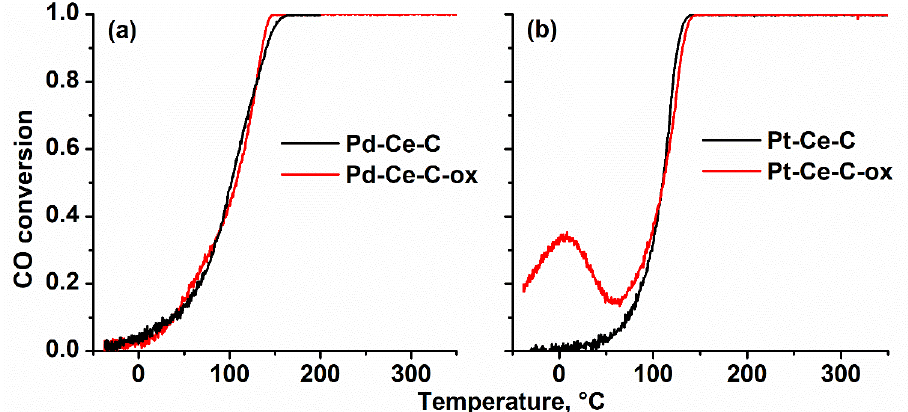
Figure 5. TPR-CO+O 2 data. The temperature dependences of CO conversion during the third heating run of the samples in the reaction mixture in the TPR-CO+O 2 mode. ( a ) Pd-Ce-C and Pd-Ce-C-ox catalysts; ( b ) Pt-Ce-C and Pt-Ce-C-ox catalysts. For the Pd-based catalysts, the observed temperature dependence of CO conversion shows a classical S-shaped behavior (Figure 5a). CO conversion is observed already at temperatures below 20–25 °C. The temperatures of 10 and 50% of CO conversion (T 10 and T 50 values) are 35 and 100 °C, respectively. It should be noted that the temperature de- pendences of CO conversion practically coincide during the second and third heating runs in the reaction mixture (see Figure A4), pointing to stability of the catalytic charac- teristics. The TPR-CO+O 2 data for the initial sample (Pd-Ce-C) and the sample treated in 1%O 2 /He (Pd-Ce-C-ox) are very similar. Thus, pretreatment of the Pd-based sample in 1%O 2 /He does not result in any noticeable changes in the catalytic characteristics. We can conclude that the Pd-Ce-O x /MWCNTs nanocomposite is characterized by high stability during heating/cooling cycles in the reaction mixture up to 350 °C and its catalytic char- acteristics are not influenced by oxidative pretreatment.